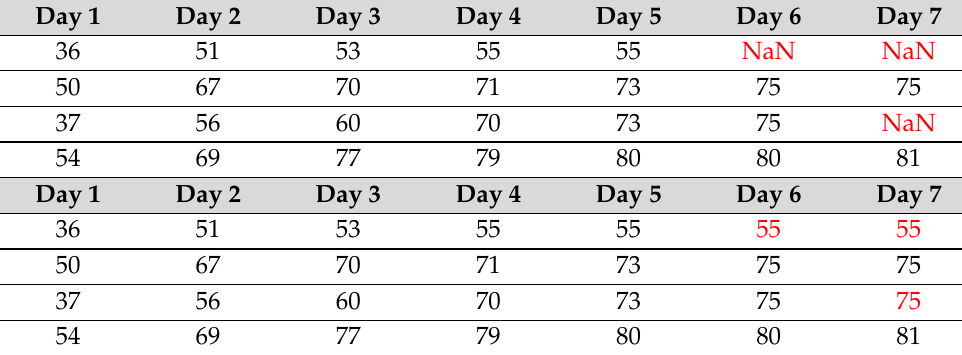
Table 1. Preprocessing of level